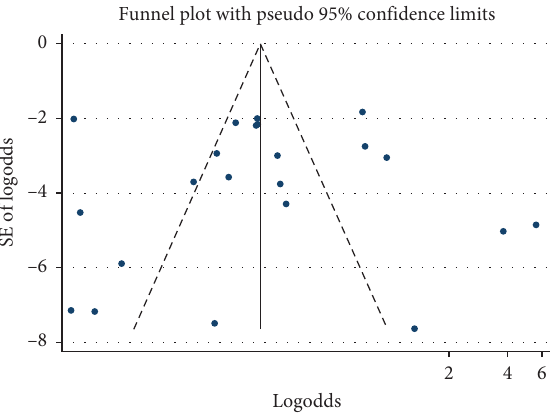
Figure 6: Funnel plot for publication bias of pooled prevalence of CPPA in Africa from 2007 to 2018